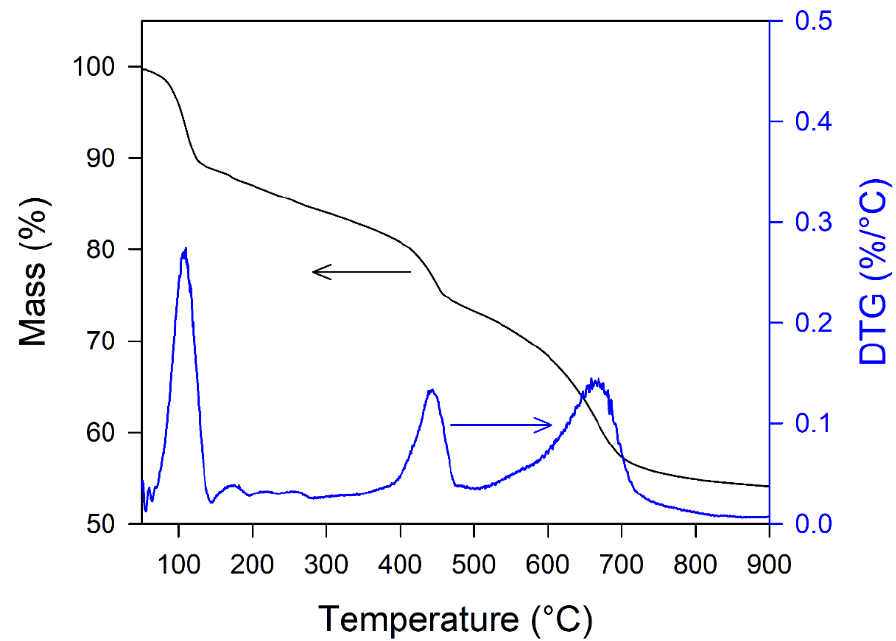
Figure 5. TGA (left, black line) and DTG curves (right, blue line) of i-Cu(II)/θ-Al 2 O 3 precursor. H 2 -TPR was used for c -Cu(I)/ θ -Al 2 O 3 , i -Cu(II)/ θ -Al 2 O 3 -350 and i -Cu(I)/ θ -Al 2 O 3 -500 to measure the reducibility of the-supported CuCl 2 in terms of temperature, as shown in Figure 6. The c -Cu(I)/ θ -Al 2 O 3 showed two H 2 -TPR peaks at 260 and 420 ◦ C. Similarly, the i -Cu(II)/ θ -Al 2 O 3 -350 and i -Cu(I)/ θ -Al 2 O 3 -500 also show two H 2 -TPR peaks at (360 and 450 ◦ C) and (270 and 440 ◦ C), respectively. These peaks were assigned to the two-step reduction of Cu 2+ to Cu + and Cu + to Cu metal, respectively [35,37]. Lower temperature calcined sample ( i -Cu(II)/ θ -Al 2 O 3 -350) was not transformed from CuCl 2 to CuCl structure in the XRD study, and Cu 2+ was mainly observed in the XPS study in Figure S1. Thus, the first reduction peak area of i -Cu(II)/ θ -Al 2 O 3 -350 was larger than those of c -Cu(I)/ θ - Al 2 O 3 and i -Cu(I)/ θ -Al 2 O 3 -500, respectively. In addition, the higher reduction temperature of i -Cu(II)/ θ -Al 2 O 3 -350 was possibly due to the larger CuCl 2 particle size on θ -Al 2 O 3 and poor dispersion [38]. In addition, the second reduction temperature of i -Cu(II)/ θ - Al 2 O 3 -350 is higher than the one of i -Cu(I)/ θ -Al 2 O 3 -500. This can also originate from dispersion differences such as the first reduction peak shift. Thus, the H 2 -TPR profile showed that i -Cu(I)/ θ -Al 2 O 3 -500 had a higher redox activity at lower temperature than i -Cu(II)/ θ -Al 2 O 3